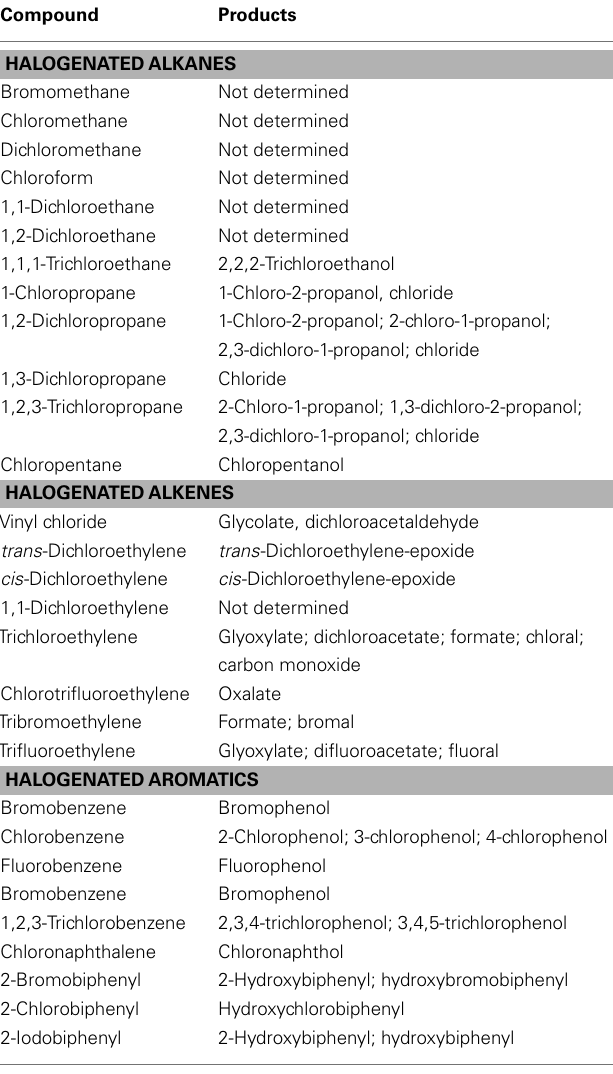
Table 1 | Distribution of pMMO and sMMO expression by methanotrophic genera.